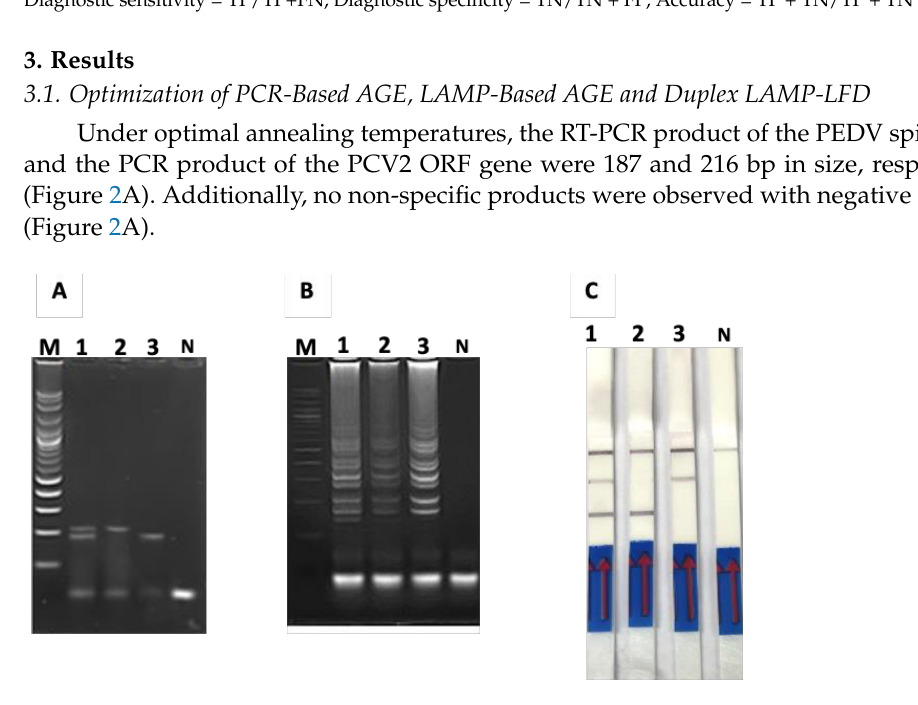
Figure 2. DNA amplification profiles of PEDV spike gene, PCV2 ORF gene, and PEDV/PCV2 co- infection using ( A ) PCR-based AGE, ( B ) LAMP-based AGE and ( C ) duplex LAMP-LFD. Lane M represents 100 bp DNA ladder marker; Lane 1 represents duplex PEDV/PCV2; Lane 2 represents PCV2; Lane 3 represents PEDV; Lane N represents negative control (without DNA template).